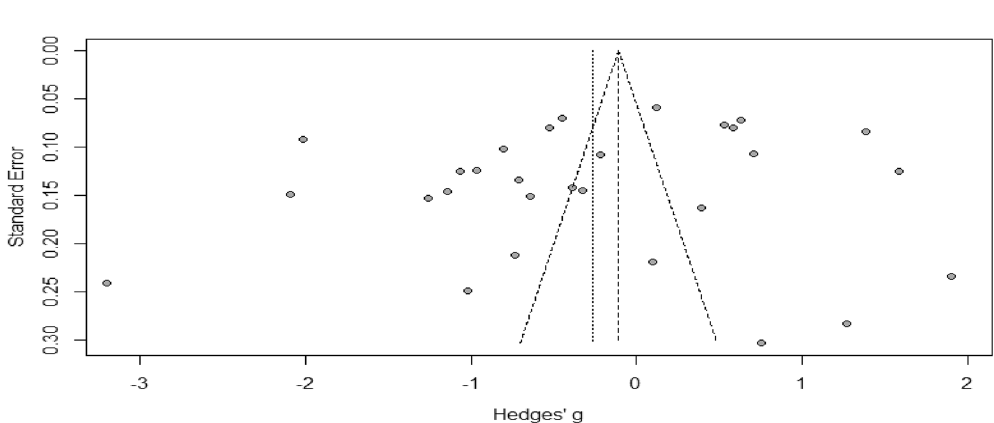
Figure 2. Funnel plot of studies included in the estimation of the proportion of tuberculosis patients and their households who faced catastrophic costs at a cut-off point of